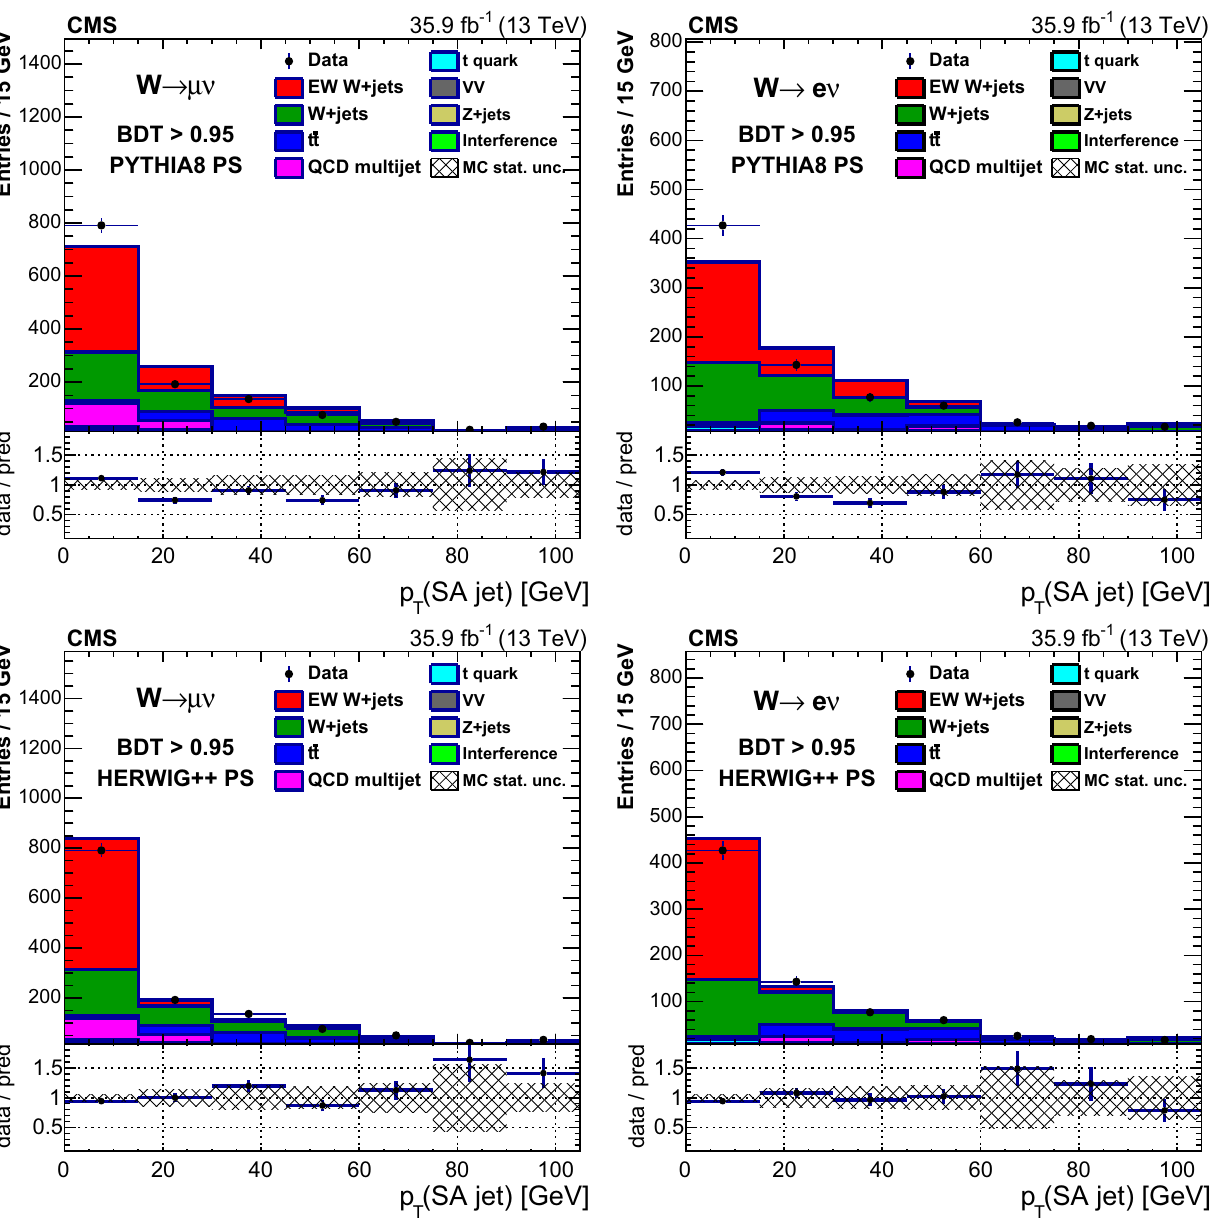
Fig. 17 Leading additional soft-activity (SA) jet p T for BDT > 0 . 95 in the muon (left) and electron (right) channels including the signal prediction from MadGraph 5_a mc@nlo interfaced with pythia parton showering (upper) and herwig++ parton showering